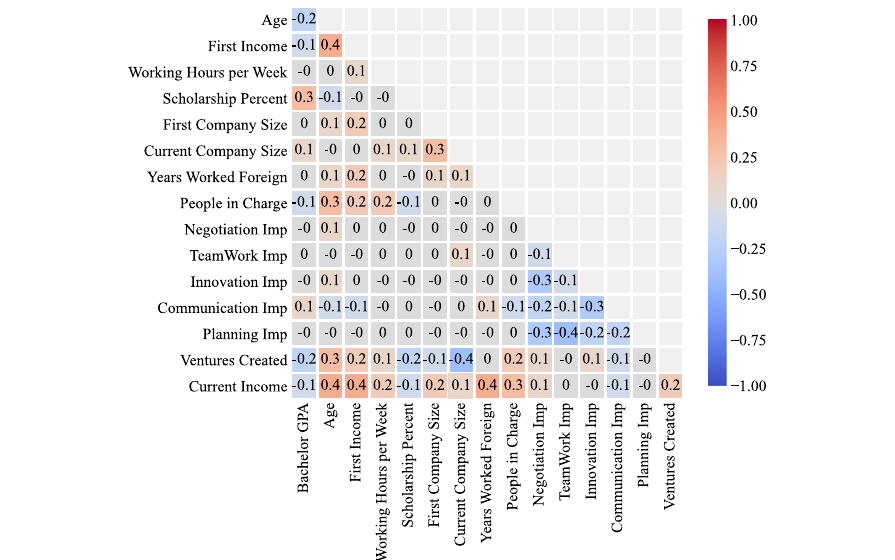
Fig. 4 Current Income Spearman correlation coefficient matrix of the continuous variables of the